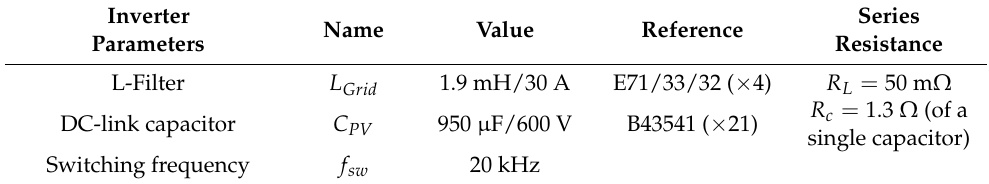
Table 4. Conventional H-Bridge